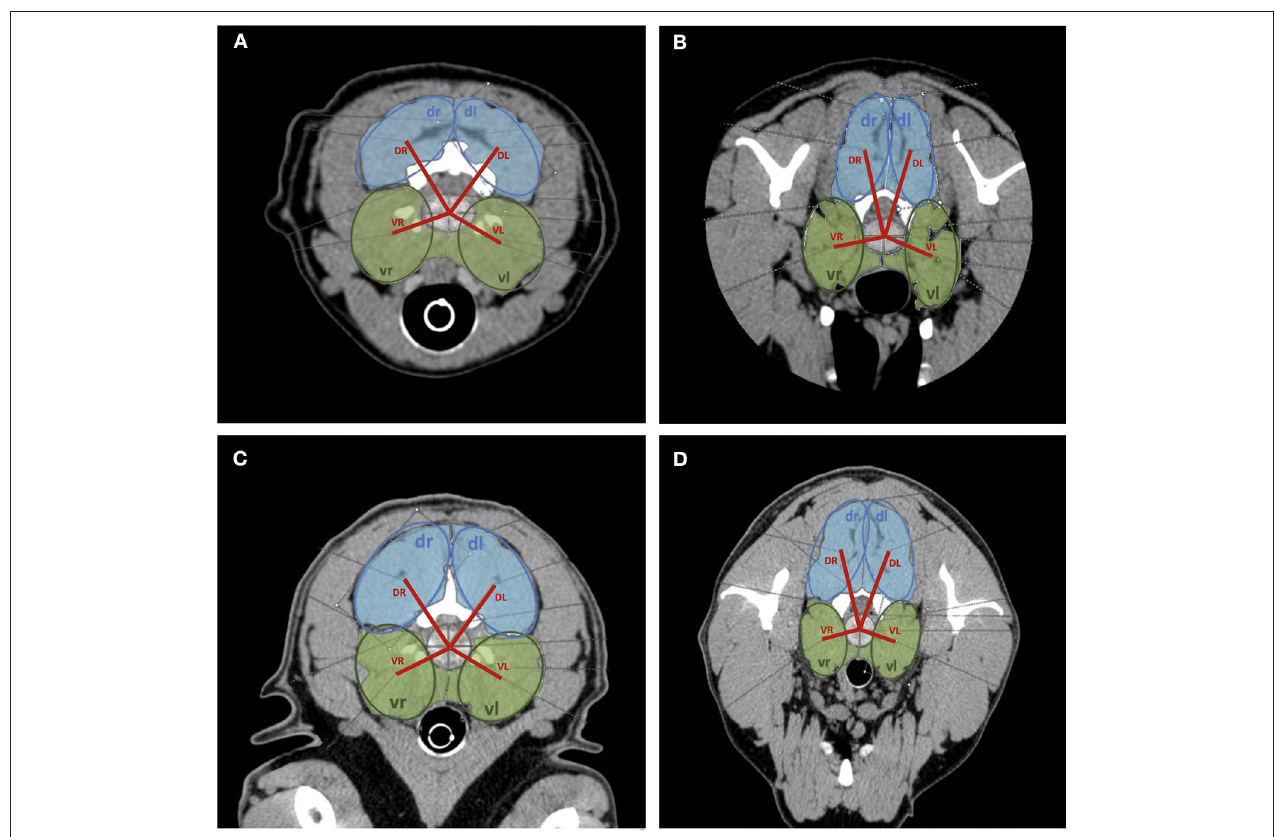
FIGURE 3 | Transversal plane CT images of cervical spine with area measurements of dorsal (light blue) and ventral (light green) paraspinal musculature. Model measurements indicated (dark blue circles = dorsal area measurements; dark green circles = ventral area measurements; red line = distance measurements from the hypothetical center of the intervertebral disk to the center of respective muscle group). (A) C2/C3 Dachshund, (B) C6/C7 Dachshund, (C) C2/C3 Labrador Retriever, (D) C6/C7 Labrador Retriever.